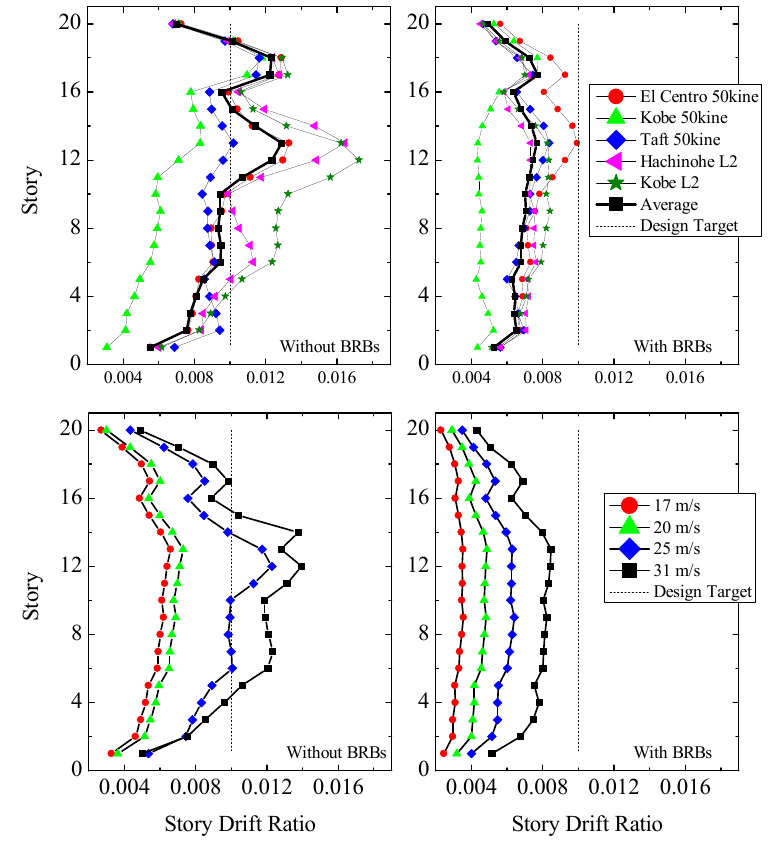
Figure 7. Maximum story drift ratio of high-rise steel building with and without BRBs under design earthquake and wind loads.